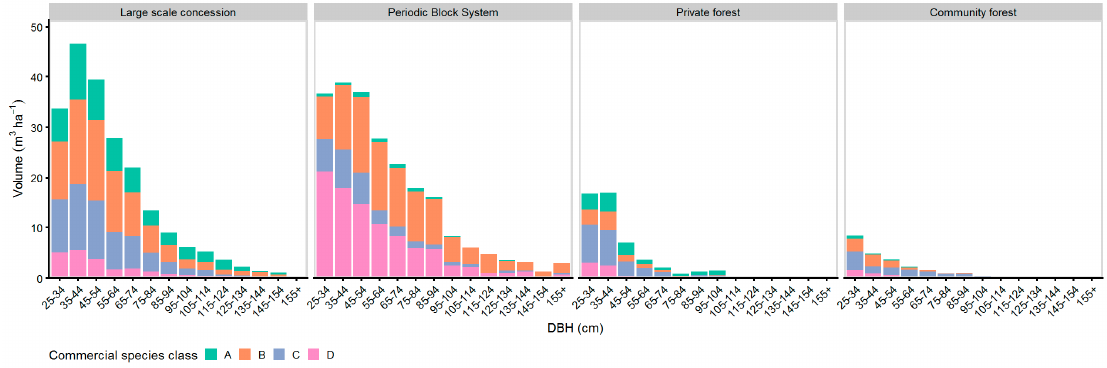
Figure 10. DBH-histogram of commercial species classes of commercial residual trees with LG 1 &